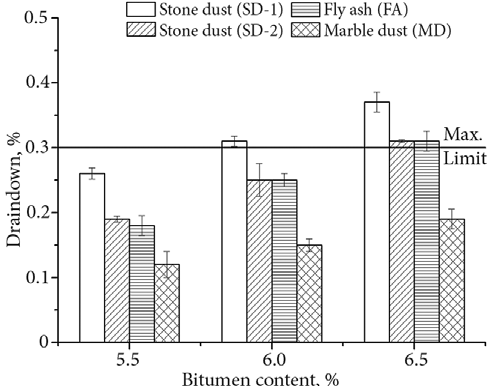
Fig. 10. Draindown of OGFC mixes